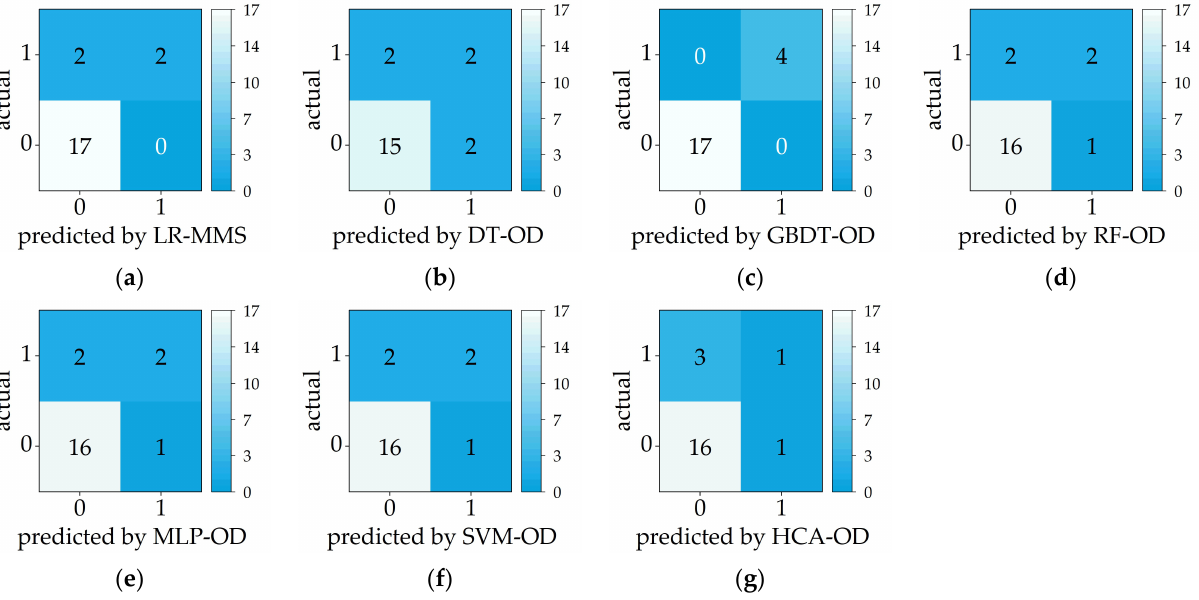
Figure 3. The confusion matrix of the best-performing models on the test set. In each subgraph, from top left to bottom right are FN, TP, TN, FP. ( a ) LR-MMS; ( b ) DT-OD; ( c ) GBDT-OD; ( d ) RF-OD;